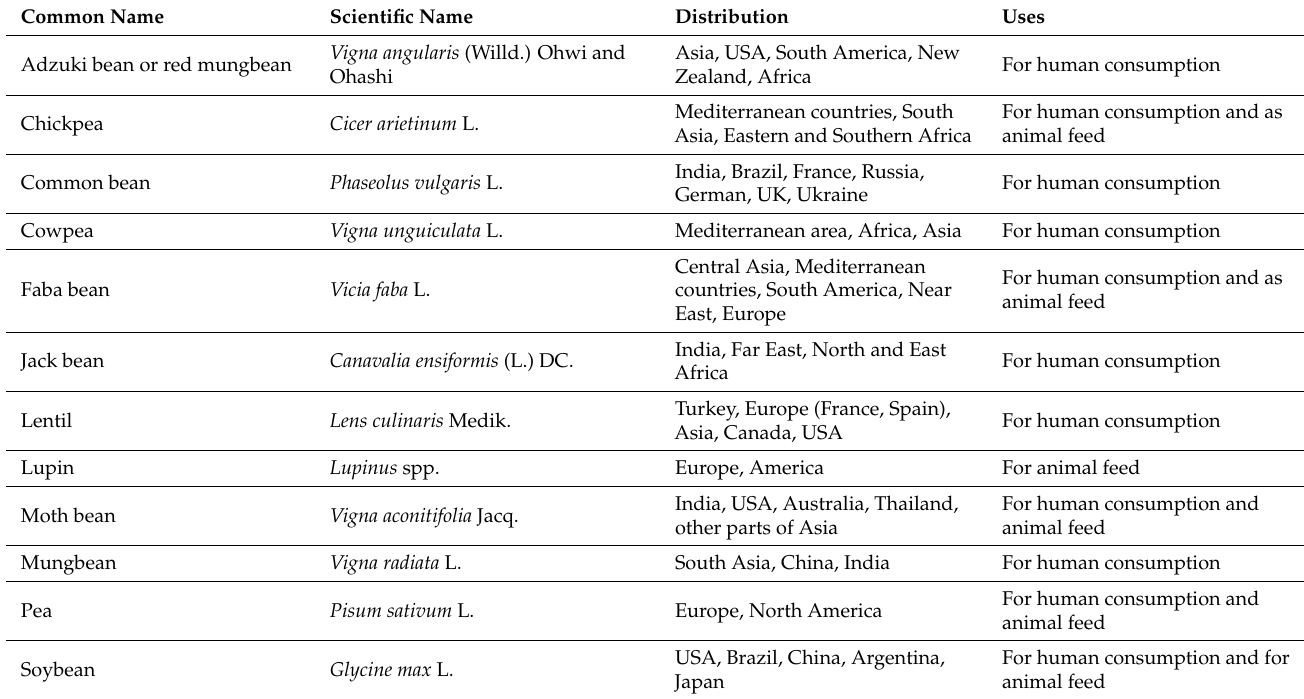
Table 1. Some examples of members of the Leguminosae family, their distribution, and their uses described in this manuscript